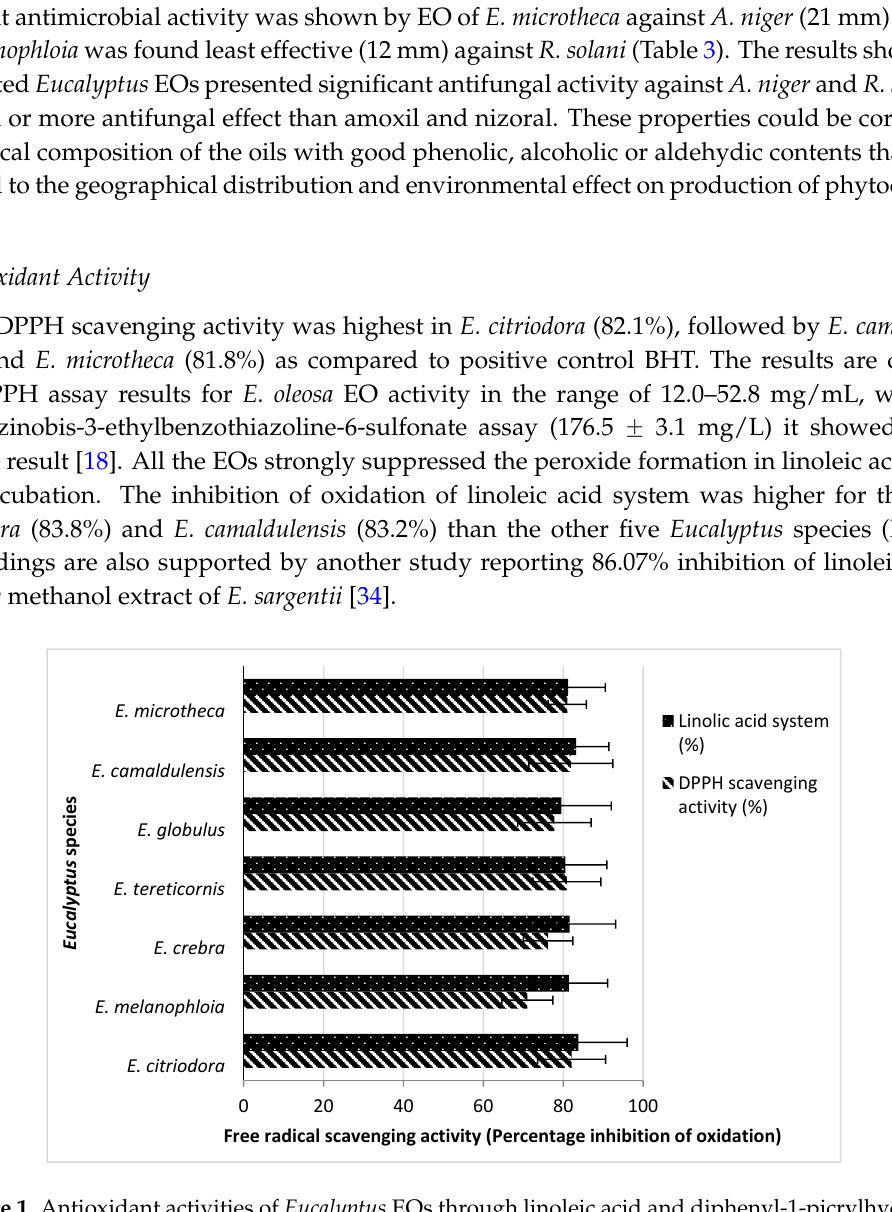
Figure 1. Antioxidant activities of Eucalyptus EOs through linoleic acid and diphenyl-1-picrylhydazyl radical scavenging assays. (Each value is mean of three).